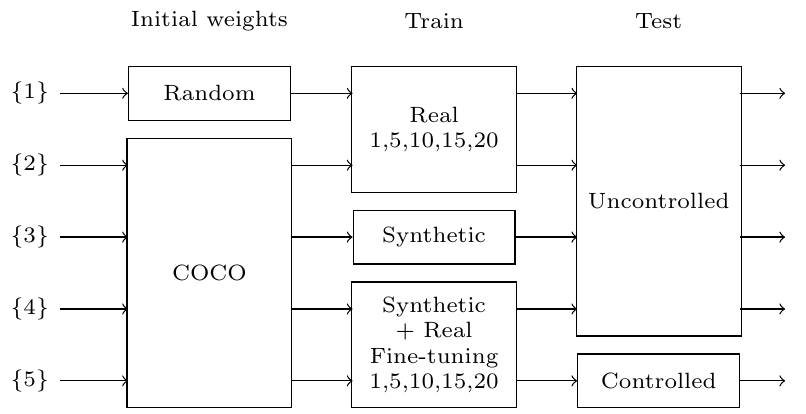
Figure 7. Schematic of differences between test